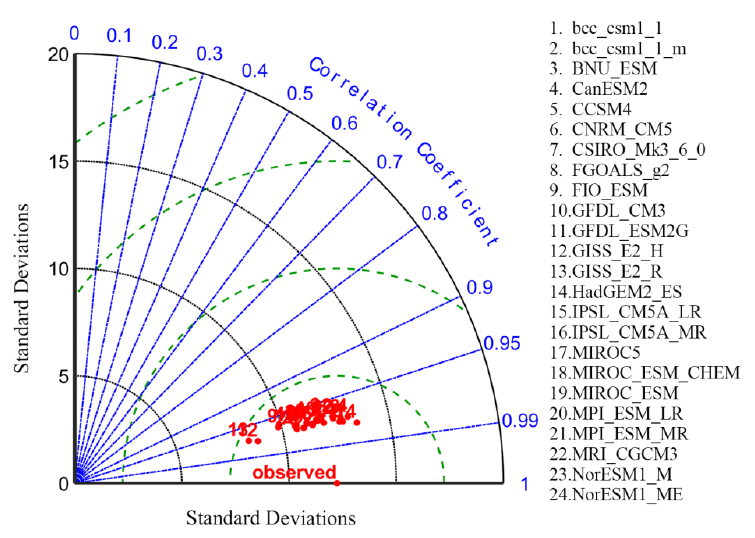
Figure 3. Annual mean SAT anomaly of the observed (CRU) data and 24 CMIP5 climate models, 1901‒2005.